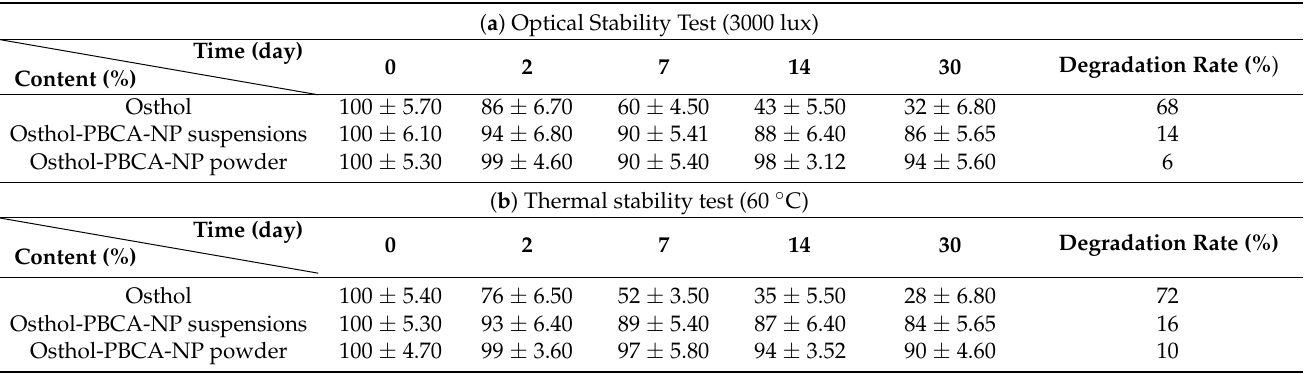
Table 6. Influencing factors test of osthol-PBCA-NP suspensions and freeze-dried powder over a period of 30 days ( n = 10).